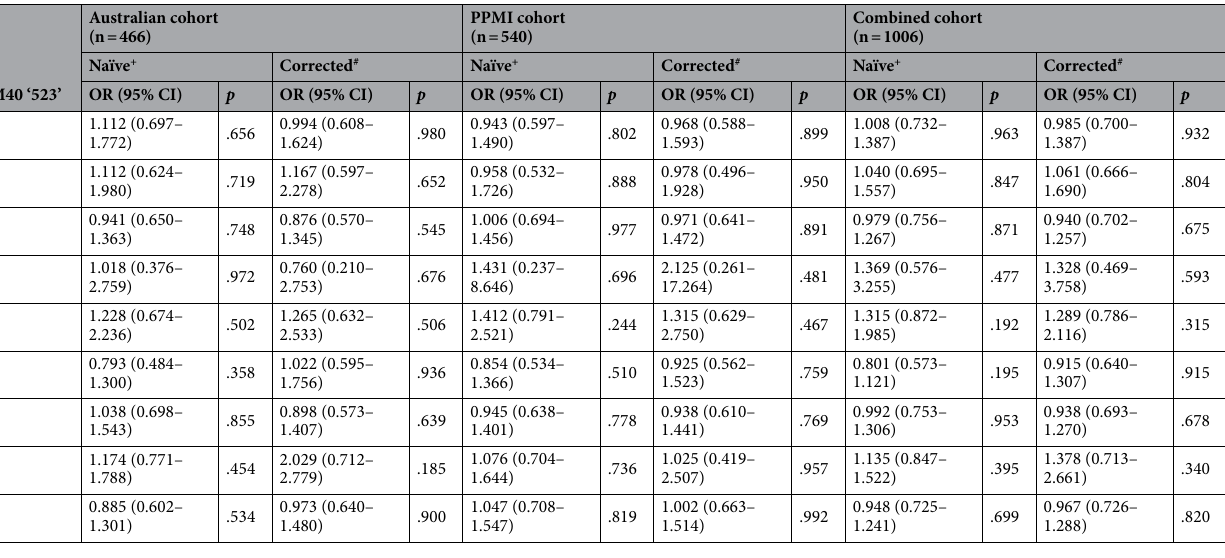
Table 2. Corrected regression models evaluating the association between ‘523’ genotype and disease risk in the two PD cohorts. + Data taken from Binary Logistic Regression models without correction for covariates. # Data taken from Binary Logistic Regression models with correction for APOE ε4 load and patient sex. P and OR (95% CI) values are calculated for the comparison to all other genotypes or alleles. PPMI, Parkinson’s Progression Markers Initiative; PD, Parkinson’s disease; OR, Odd’s Ratio ; CI, confidence interval; p , statistical significance ( p value); S/S, short/short; S/L, short/long; S/VL, short/very long; L/L, long/long; L/VL, long/very long; VL/VL, very long/very long; S, short; L, long; VL, very long.